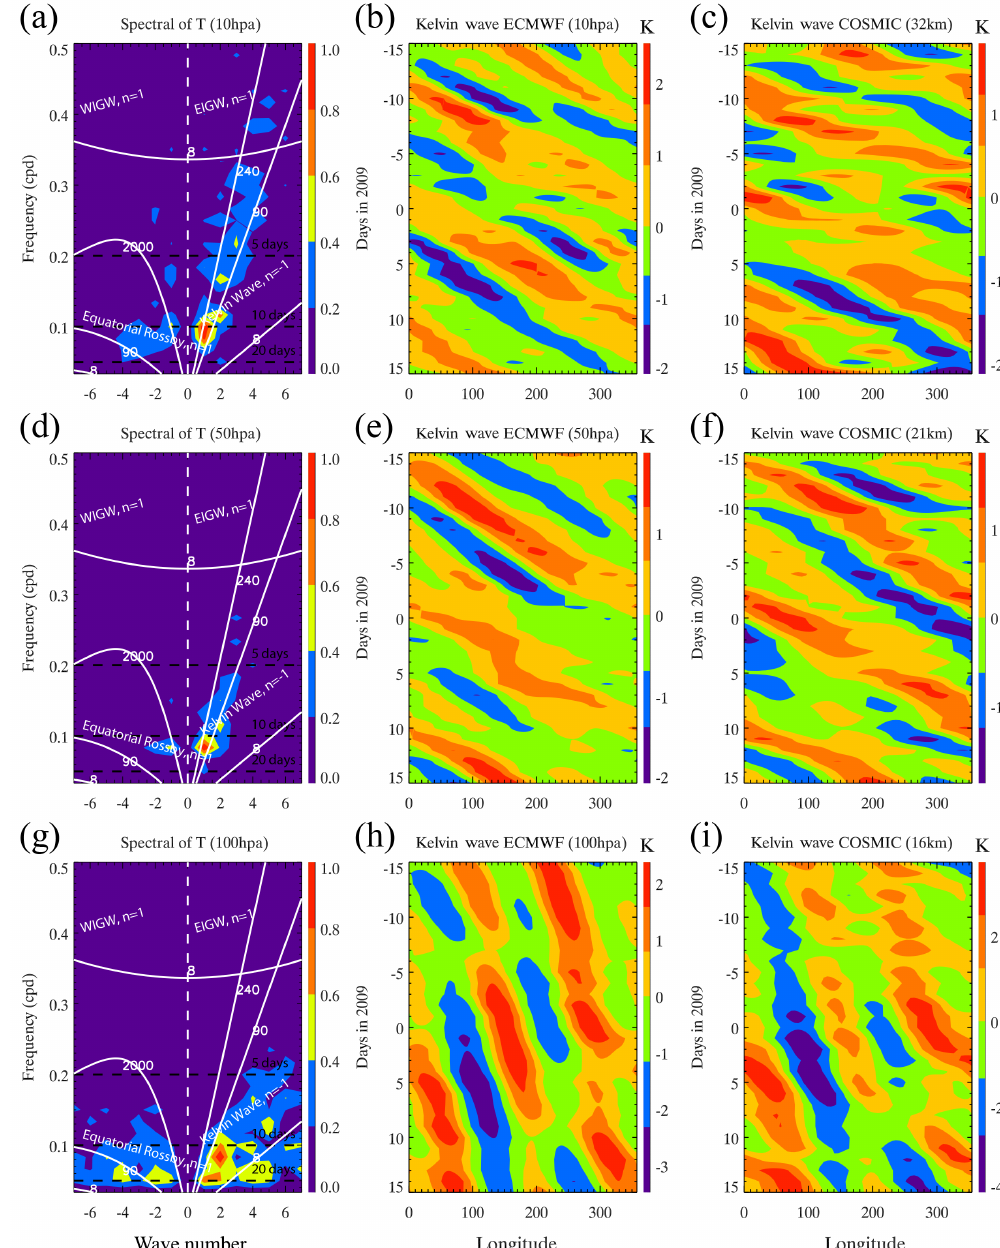
Figure 4. The normalized wavenumber and/or frequency spectra of the symmetric temperature perturbations using ERA-Interim reanalysis data (a, d, g) , the time–longitude cross section of Kelvin wave variances derived from ERA-Interim data (b, e, h) and COSMIC data (c, f, i) at 100hPa (roughly 16km, bottom), 50hPa (roughly 21km, middle), and 10hPa (roughly 32km, top) during the 2009 SSW event. The white curves in (a) , (d) and (g) represent the dispersion relation of different wave components for different equivalent depth.